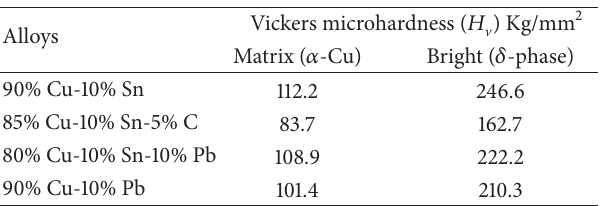
Table 1: Vickers microhardness values in Kg/mm 2 of hot pressed Cu-Sn